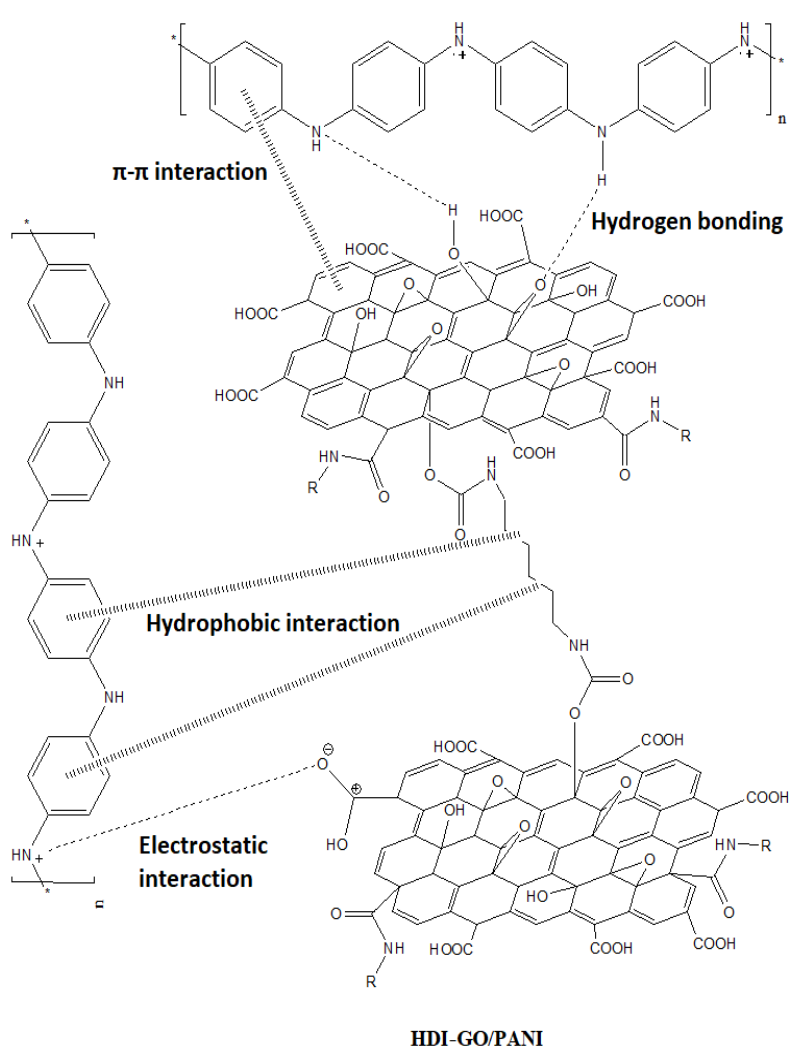
Scheme 3. Representation of the di ff erent types of interactions between PANI and HDI-GO.